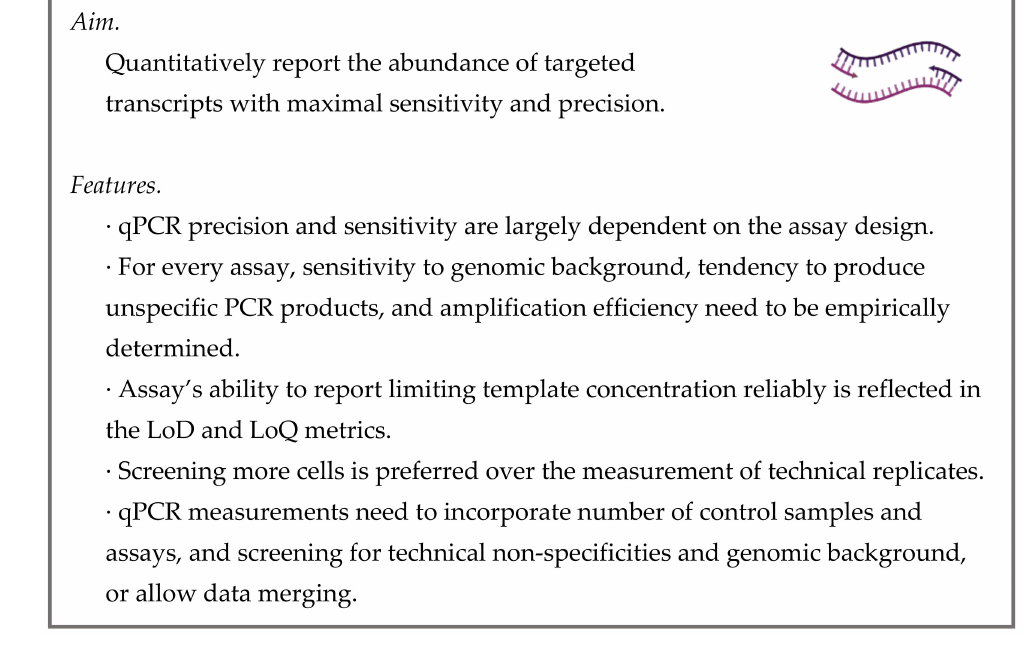
Figure 5. Quantitative